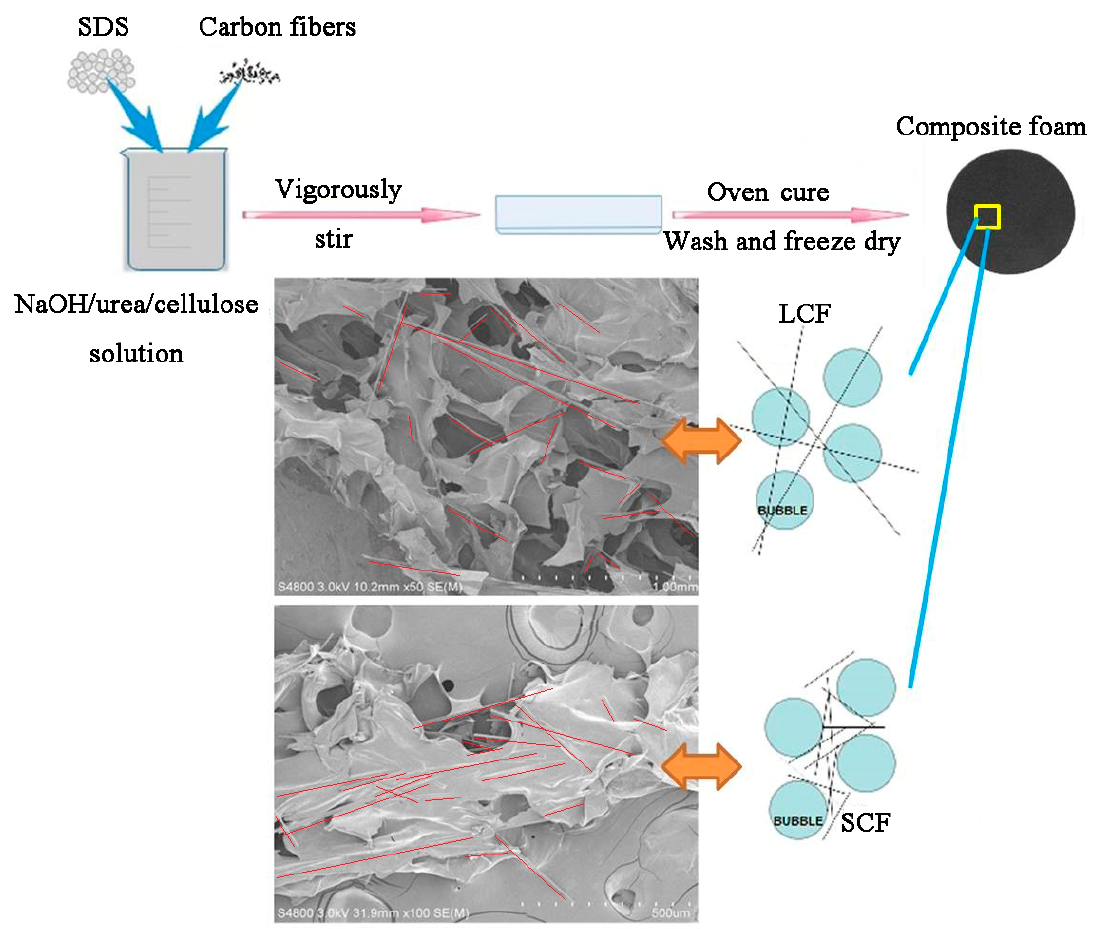
Figure 1. Schematic diagram of the production process of the composite foams, and of the foam structure.